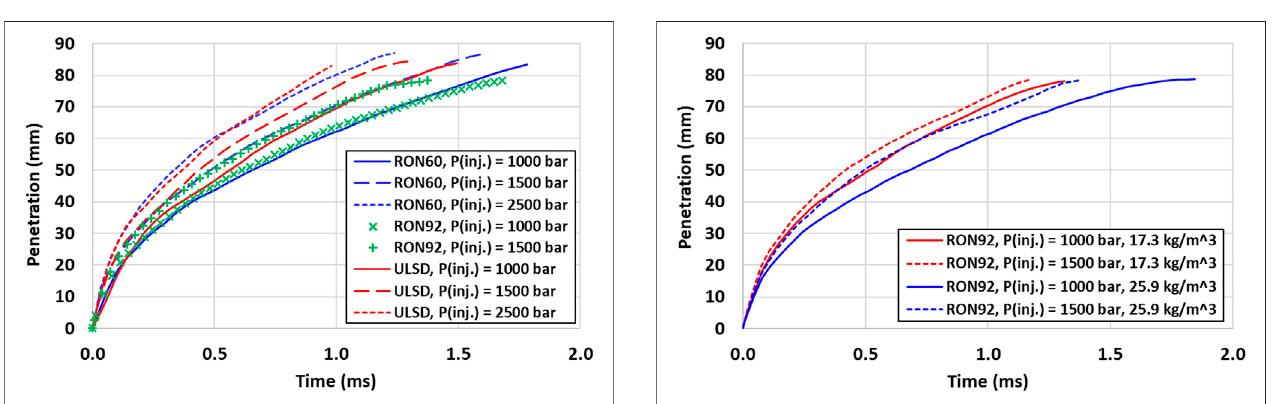
FIGURE 16 | Injection pressure effect on non-vaporizing penetration for RON92